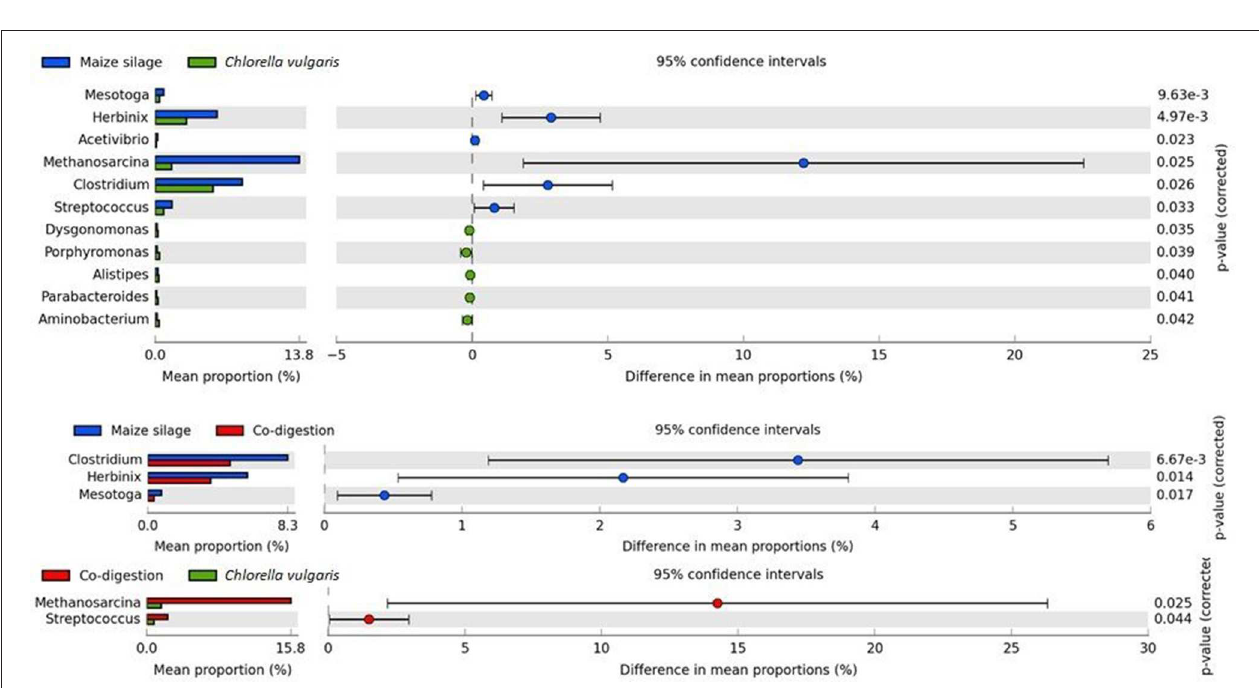
FIGURE 6 | Significant differences in core microbial communities. Significances were determined with two-sided White’s non–parametric t -test at 0.95 confidence.